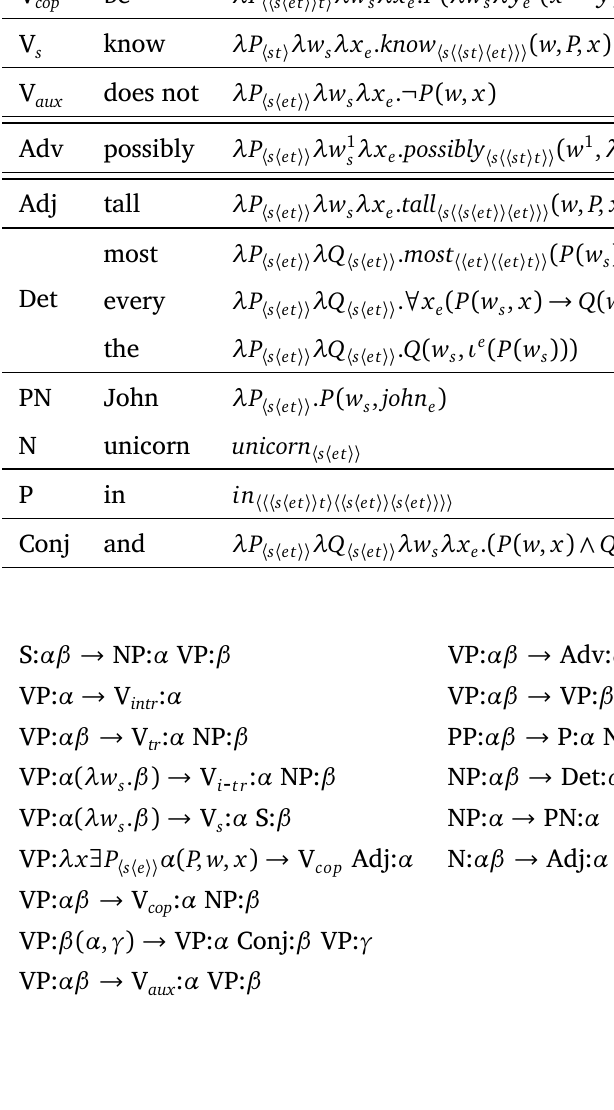
Figure 1: Lexical Entries. For every category, an example word is given